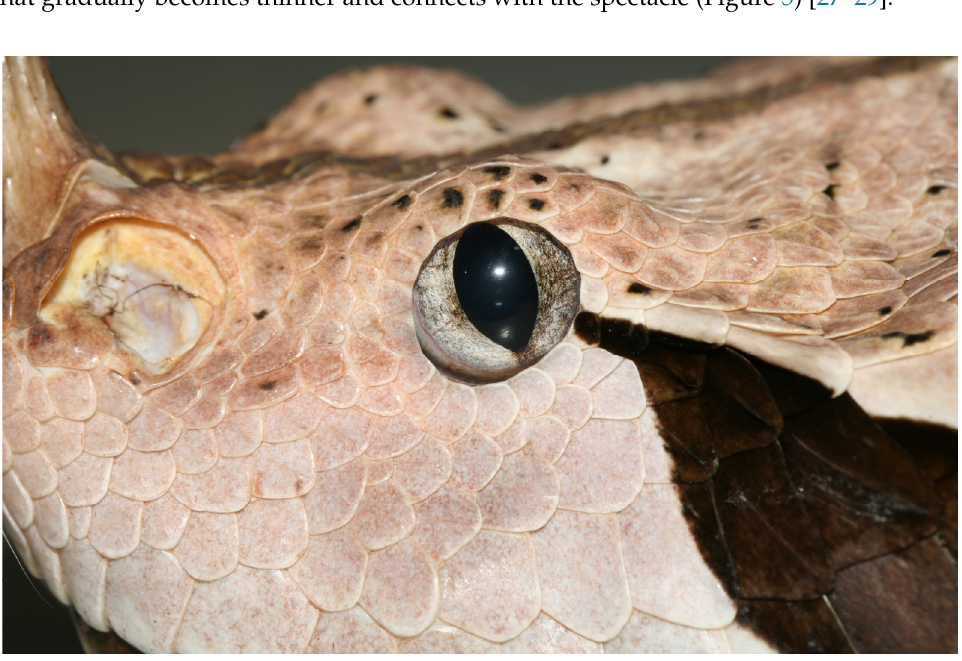
Figure 5. The transition zone between the periocular scales and the spectacle can be clearly distin- guished in this West African Gaboon viper ( Bitis gabonica rhinoceros).